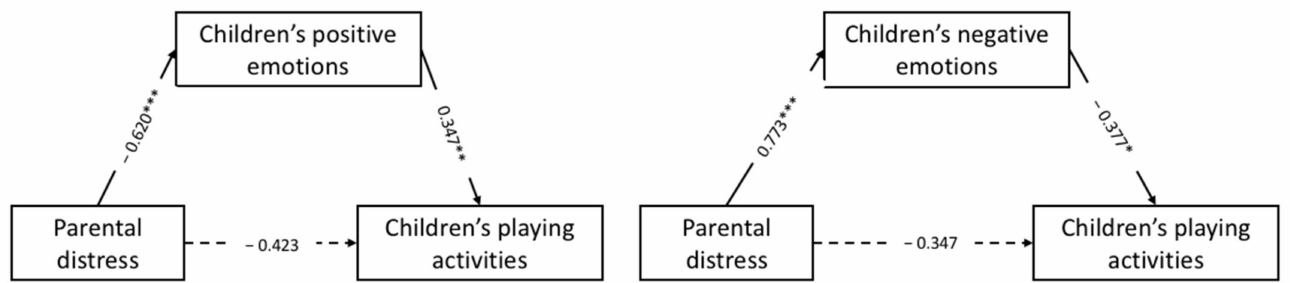
Figure 2. Models testing the mediation relationships. * p < 0.05; ** p < 0.01; *** p <